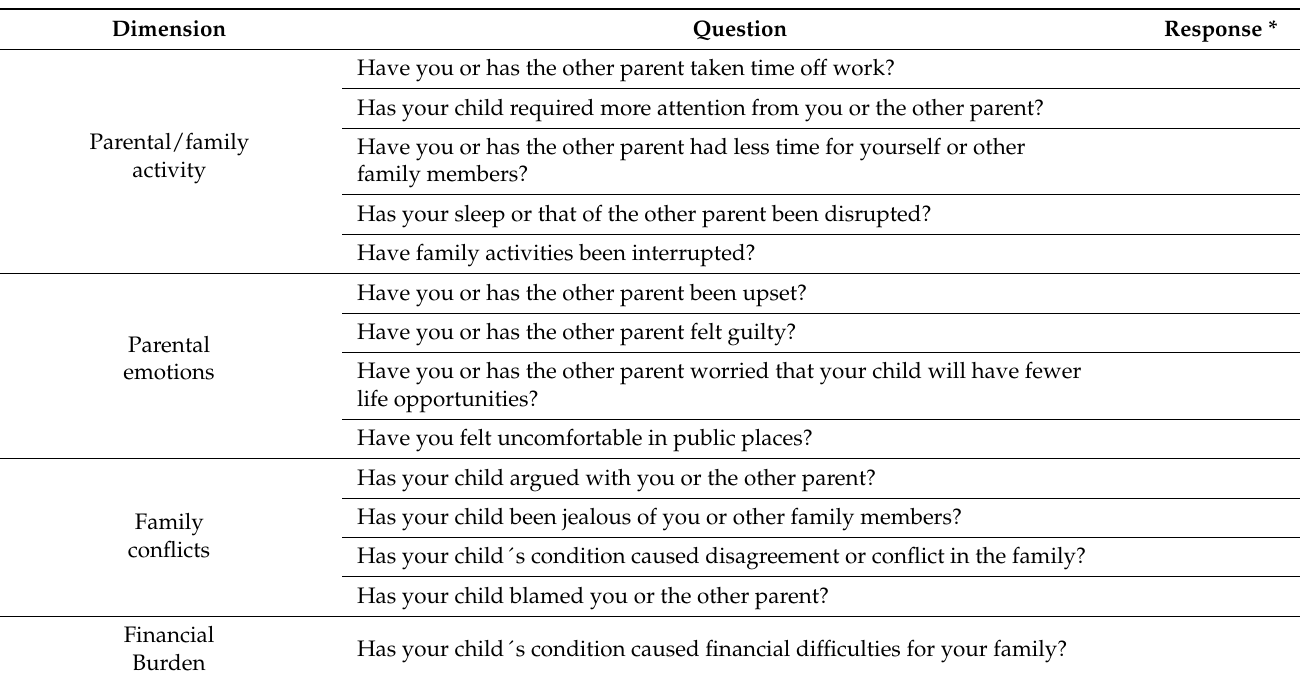
Table A2. FIS Questionnaire. * O = never, l = hardly ever. 2 = occasionally 3 = fairly often, 4 = very